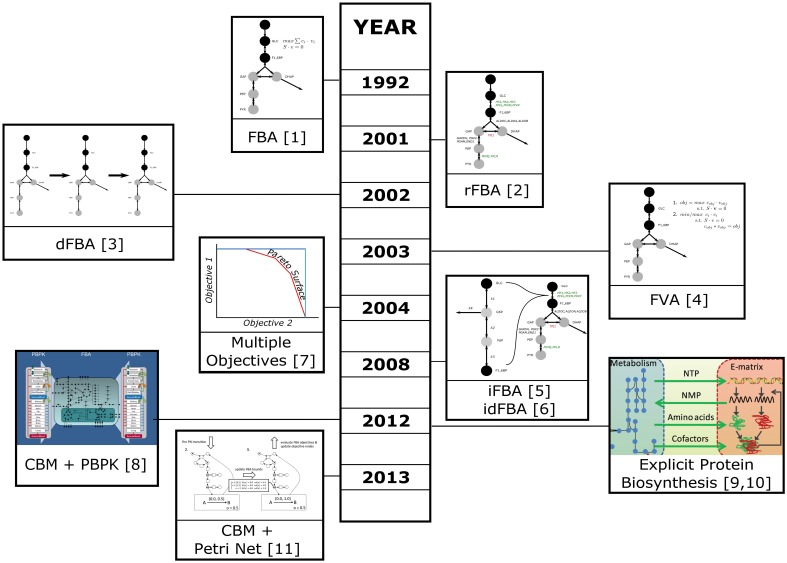
Timeline of the development of techniques for the integration of data and the simulation and analysis of complex systems. Please refer to the main text for details. ([1] Savinell and Palsson (1992); [2] Covert et al. (2001); [3] Mahadevan et al. (2002); [4] Mahadevan and Schilling (2003); [5] Covert et al. (2008); [6] Lee et al. (2008); [7] Vo et al. (2004); [8] Krauss et al. (2012); [9] Thiele et al. (2012); [10] Lerman et al. (2012); [11] Fisher et al. (2013)), Images for [8],[9], and [10] are derived from images taken from the respective publications which are provided under a Creative Commons attribution license (https://creativecommons.org/licenses/by/2.0/).